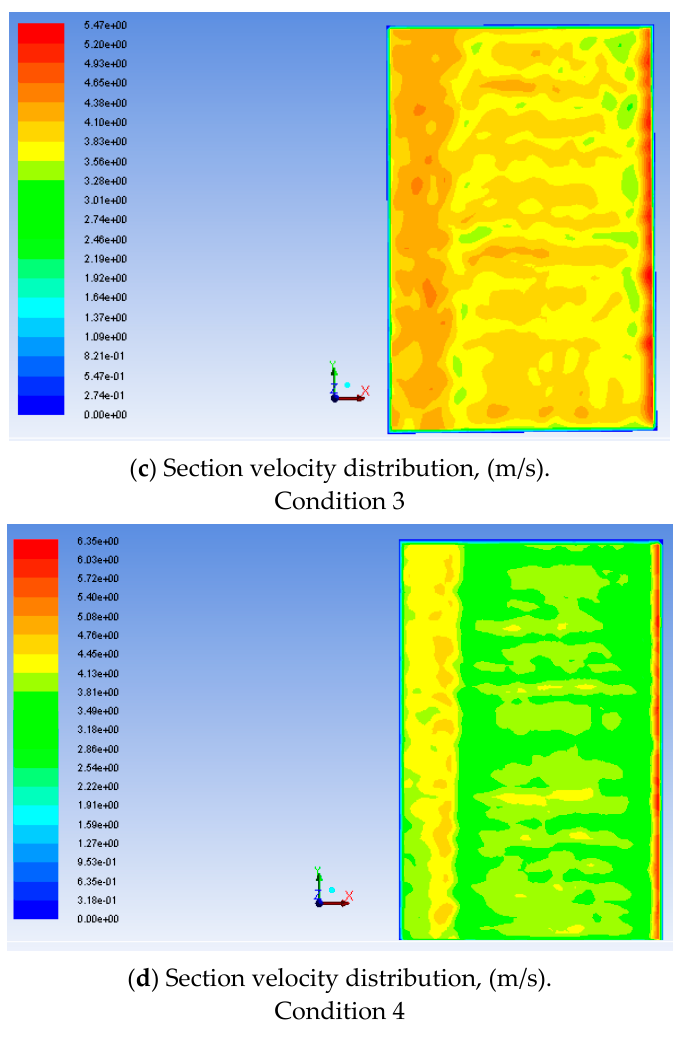
Figure 6. Velocity distribution at the upper cross section of the catalyst. ( a ) Condition 1; ( b ) Condition 2; ( c ) Condition 3; ( d ) Condition 4.